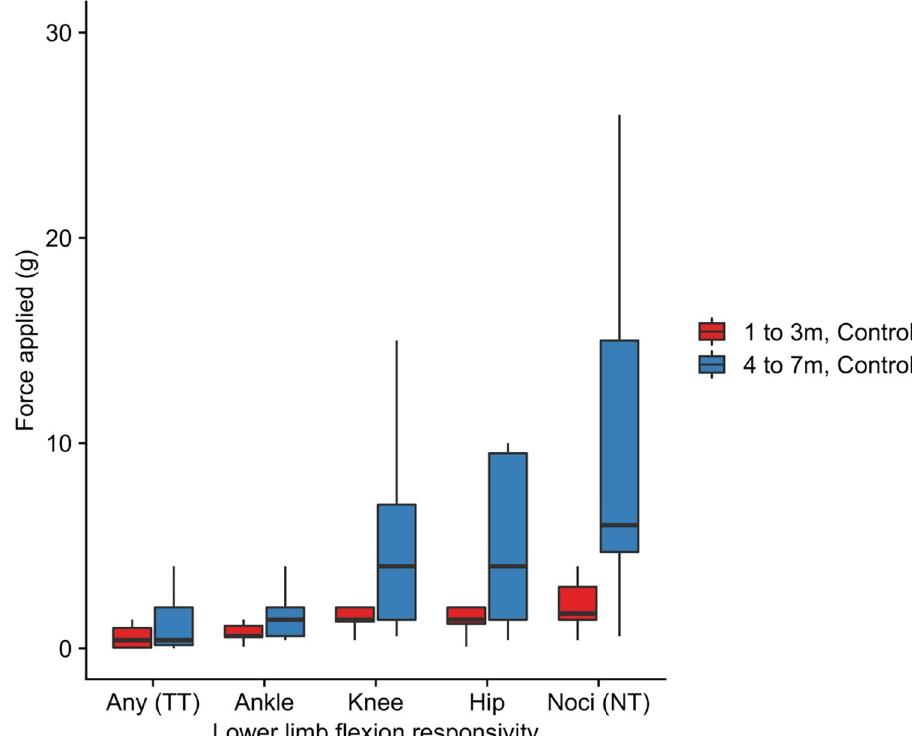
Fig 4. Sensory thresholds for lower limb flexion responsivity when evoked by graded stimulation at age 1 to 3m (n = 21) and 4 to 7m (n = 19) in the control group. Abbreviations: g = grams; m = months; TT = tactile threshold; NT = nociceptive threshold. Definitions: Tactile threshold = average lowest stimulus intensity required to generate any visible motion of the ankle, knee or hip; Nociceptive threshold = average stimulus intensity required to evoke brisk leg withdrawal away from the stimulus, consisting of knee- or hip-flexion.